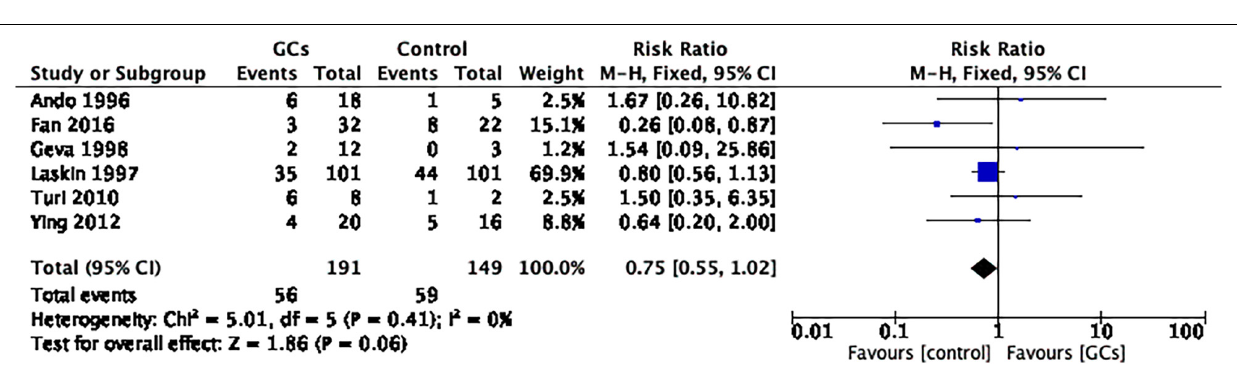
FIGURE 7 | Forrest plot for comparison: glucocorticoids versus no glucocorticoids/placebo, outcome: III. I Miscarriage rate per clinical pregnancy. The use of peri-implantation glucocorticoids on the miscarriage rate per couple showed no statistical significance compared to no glucocorticoids (RR 0.75, 95% CI 0.55–1.02, p = 0.06, six cohort studies, 340 women, I 2 =